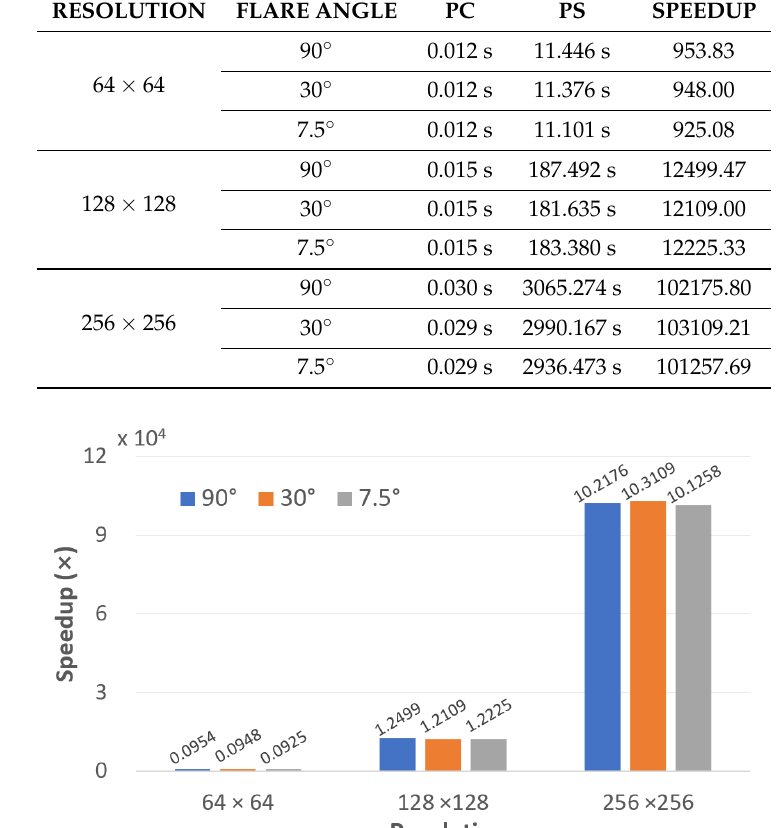
Figure 7. Speedup variation with the change in resolution and flare